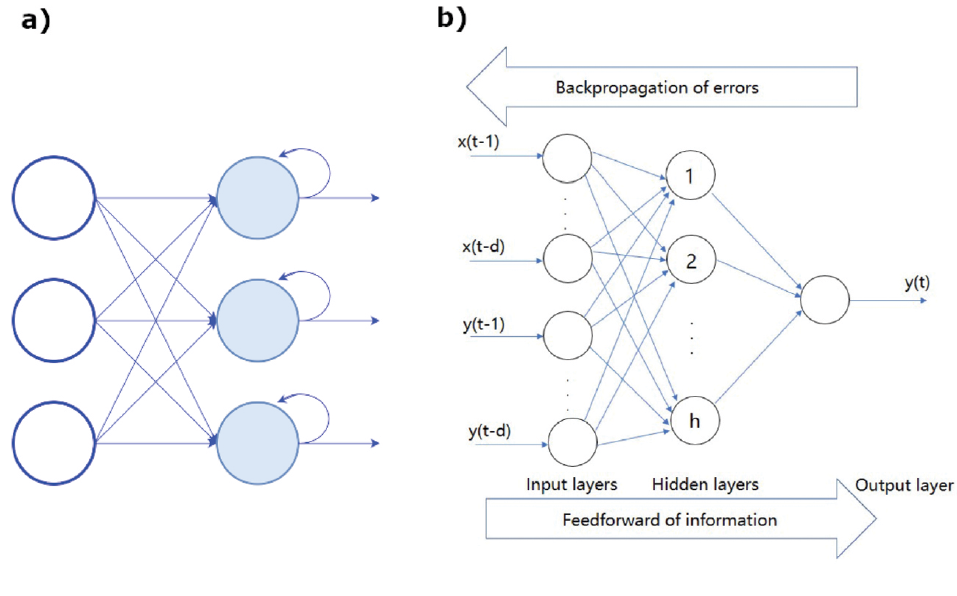
Figure 18. ( a ) Scheme of a RNN. ( b ) Example of a BP network architecture. Figure reprinted from Ref. [109] under the terms of CC BY-NC-ND 4.0